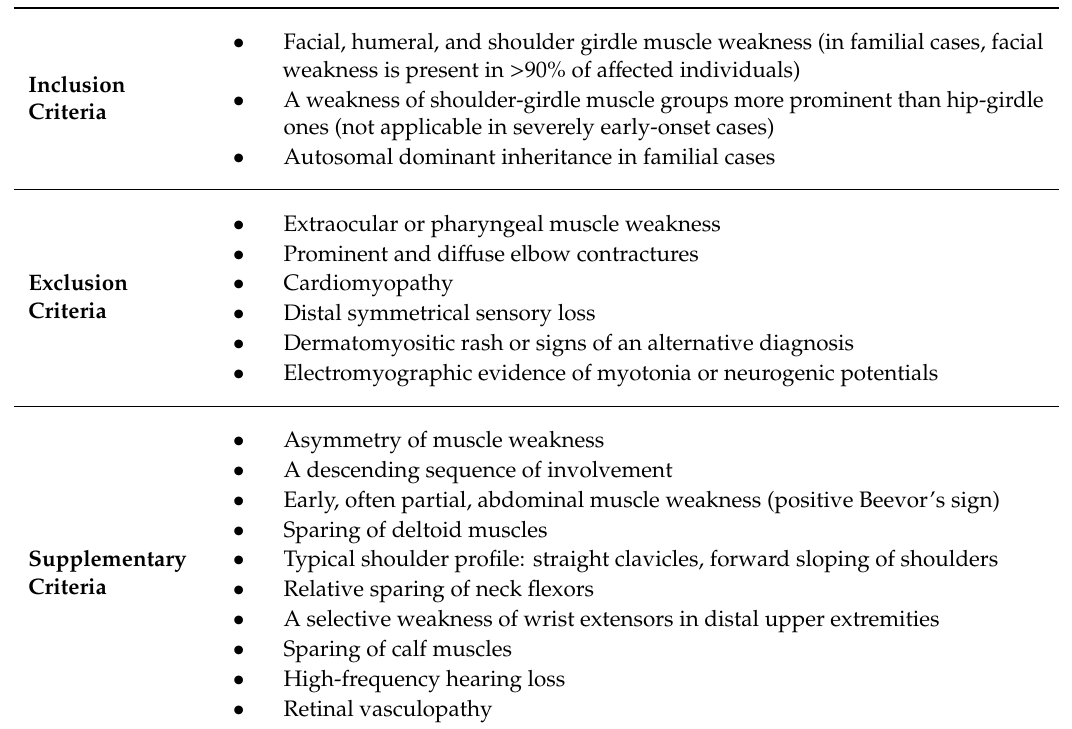
Table 1. Diagnostic criteria for facioscapulohumeral dystrophy